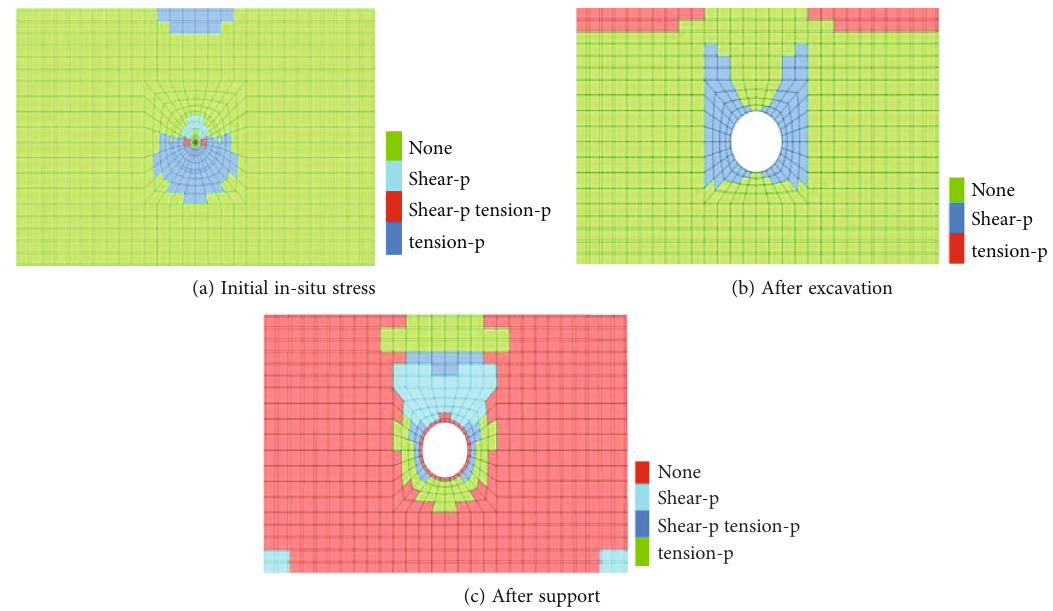
Figure 22: Distribution of plastic